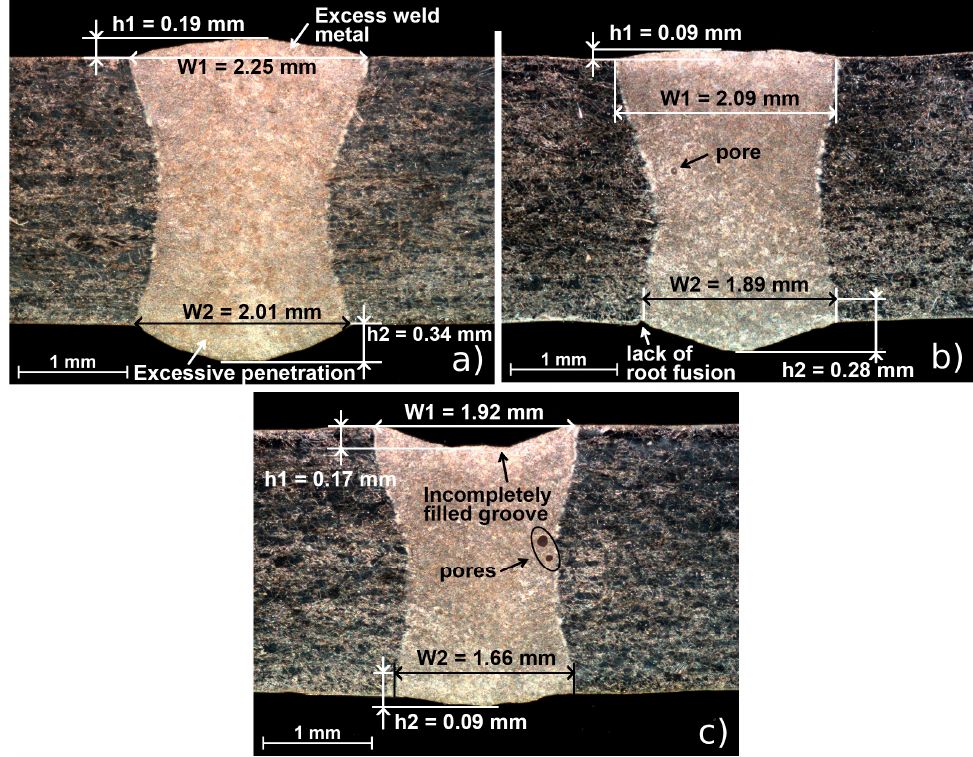
Figure 3. Cross-sections of laser weld joints: ( a ) 130 cm/min, ( b ) 70 cm/min, ( c ) 0 cm/min.